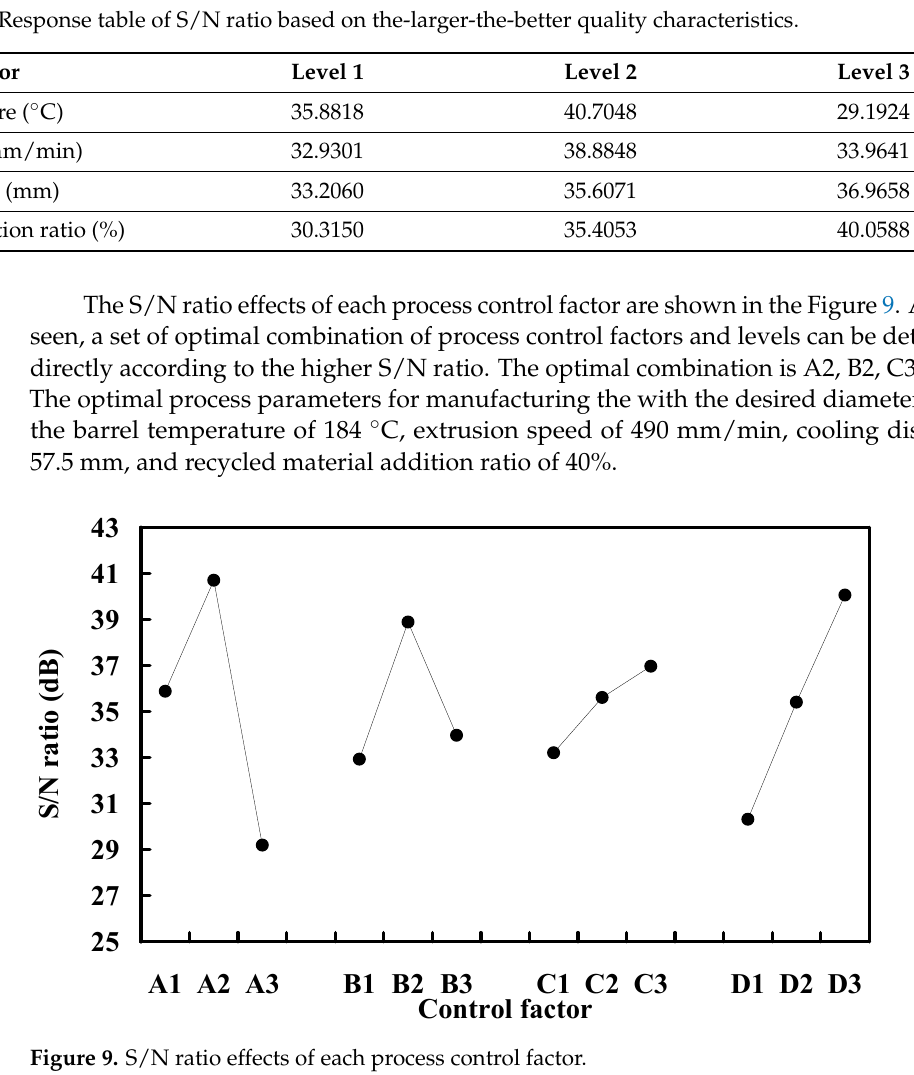
Table 4. ANOVA table.